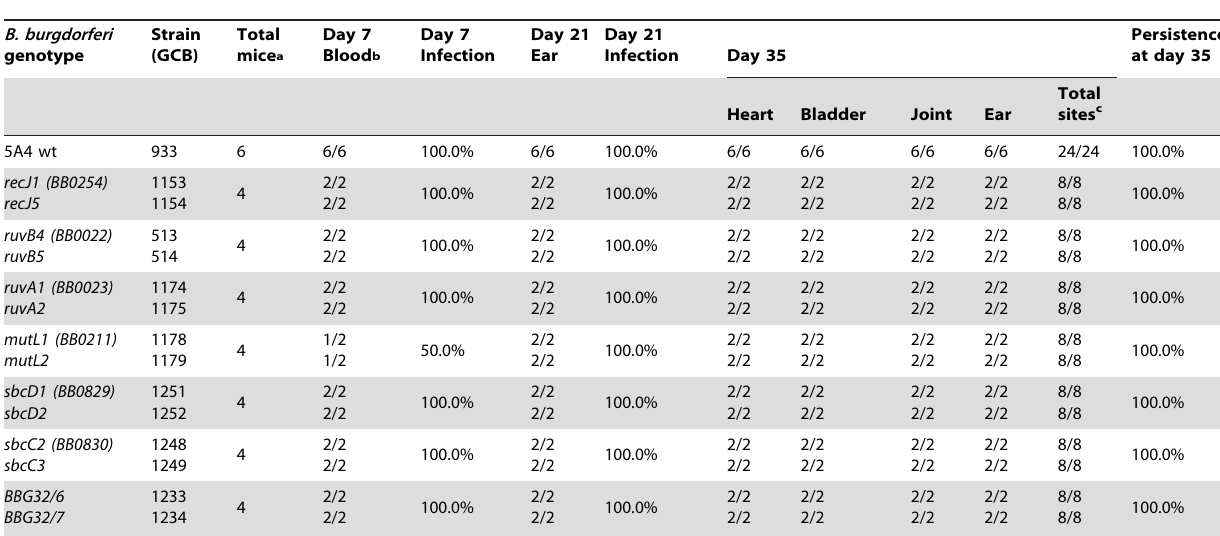
a Total number of mice examined for genotype. b Values listed correspond to number of cultures positive/number of sites tested. c Number of positive tissue sites/number of sites tested.